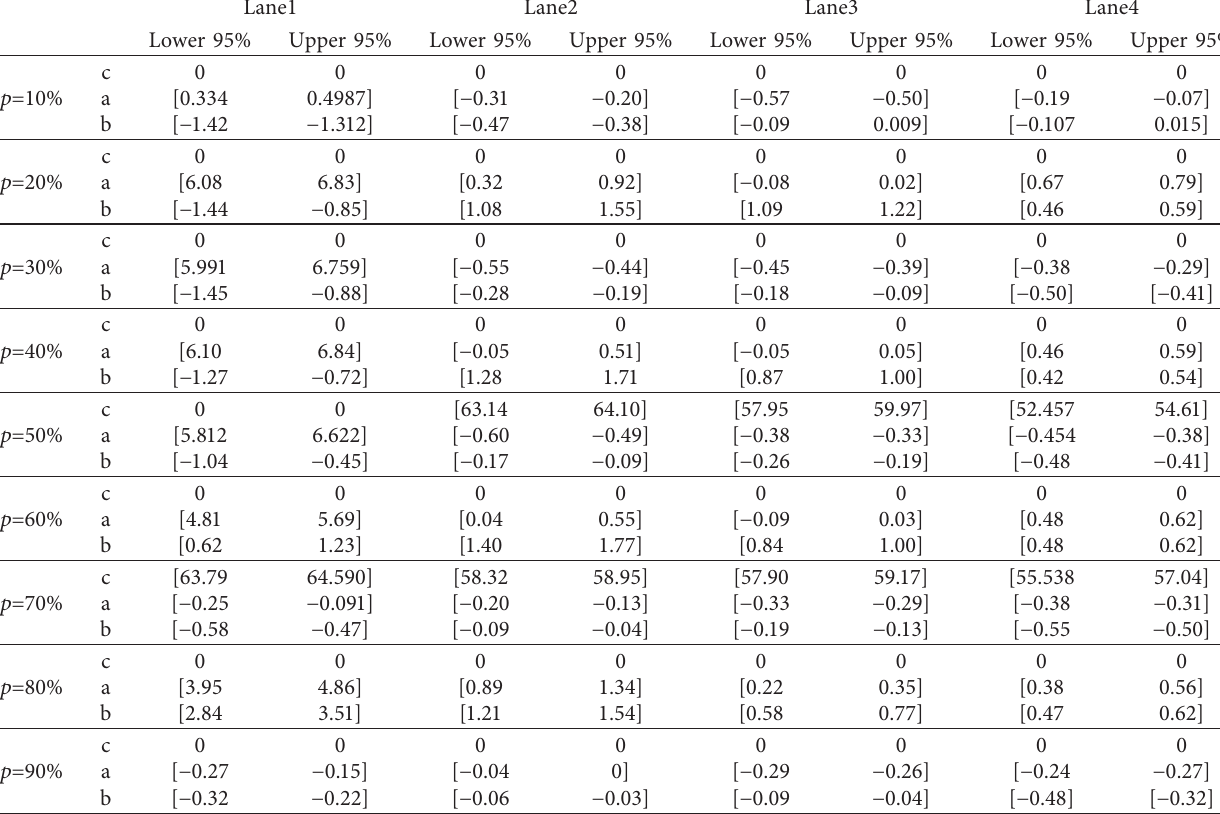
Table 7: The parameter value interval table of the regression equation under different penetration rates of autonomous vehicles. Lane1 Lane2 Lane3